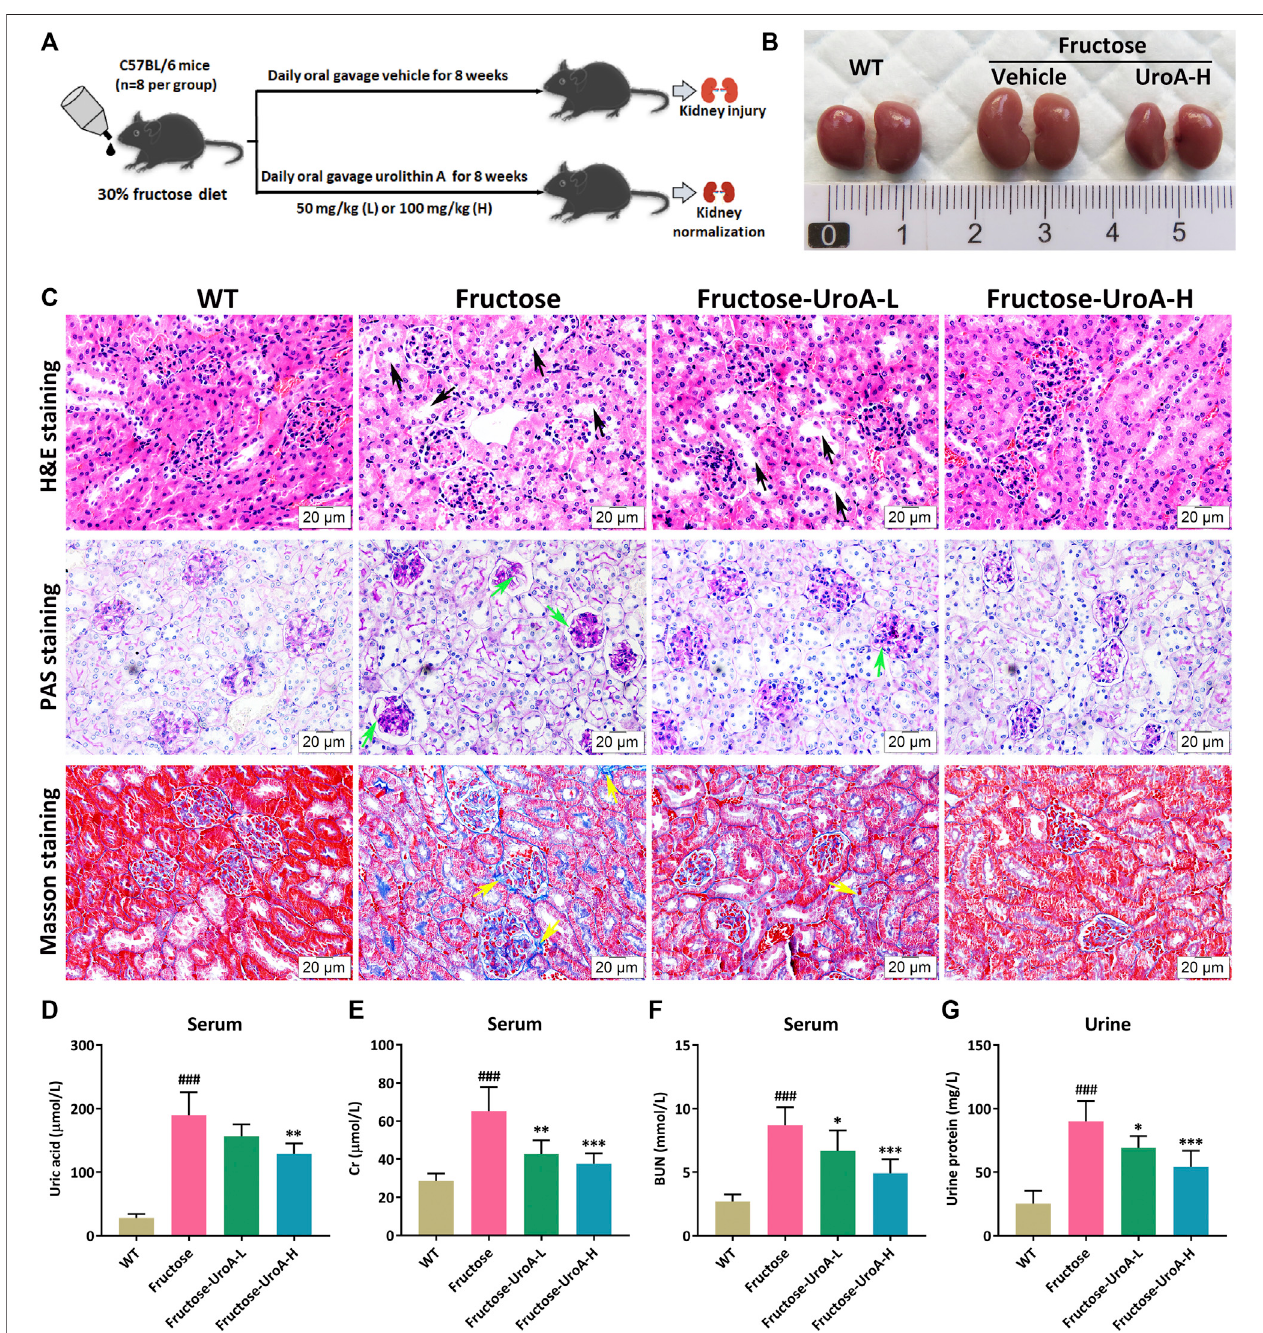
FIGURE 1 | Urolithin A (UroA) ameliorates fructose-induced hyperuricemic nephropathic in mice. (A) Study design. (B) Kidney macroscopic appearance. (C) Hematoxylin-eosin (H&E), Periodic Acid-Schiff (PAS), and Masson ’ s trichrome staining of kidney tissues from the wild-type (WT) or fructose-fed mice with intragastric administration of either vehicle or UroA, respectively (Scale bar: 20 μ m). Fructose-fed mice showed obvious pathological changes in kidney tissues, including tubular hypertrophy anddilation(black arrow),glomerularbasementmembranethickening (greenarrow),and collagendeposition(yellowarrow). (D – G) Fructose-fedmice exhibitedadeclineinserumuricacid (D) ,creatinine(Gr) (E) ,bloodureanitrogen(BUN) (F), andurineprotein (G) afterreceivingUroAtreatmentfor8weeks.Mean±S.D., n = 8. ### p < 0.001 versus the WT group; * p < 0.05, ** p < 0.01, *** p < 0.001 versus the fructose group. UroA-L and UroA-H represent intragastric administration of urolithin A at low (50 mg/kg/day) and high (100 mg/kg/day) doses, respectively.